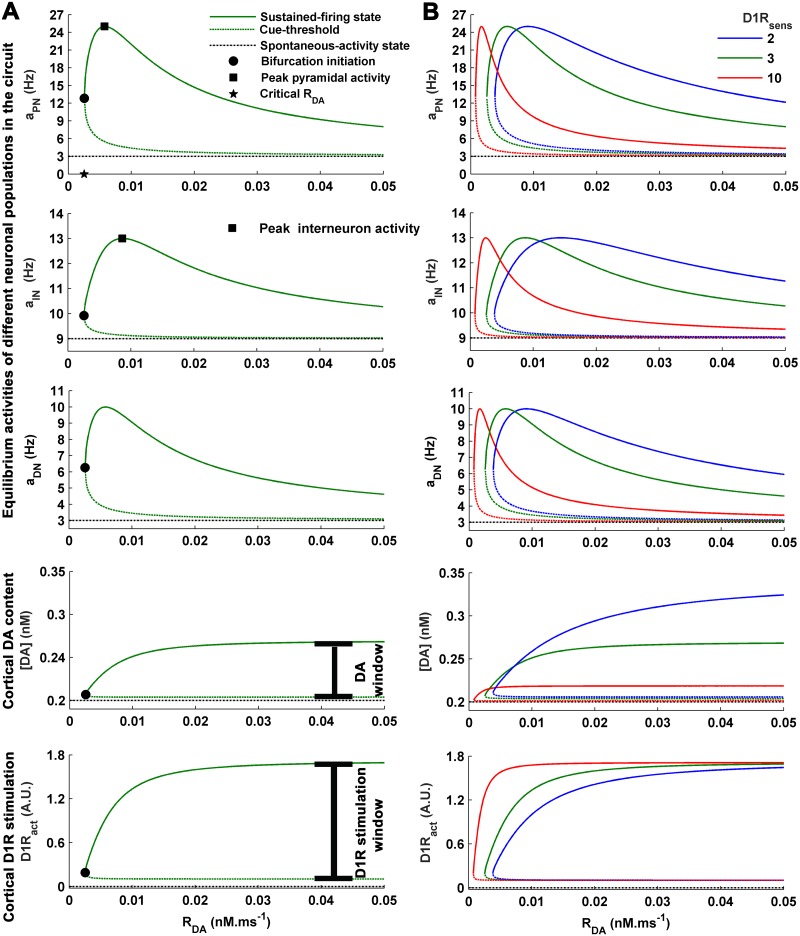
The delay-associated state of the mesocortical dynamics is characterized by the global equilibrium state of its various dynamical elements.(A) Given a fixed value of D1R-sensitivity D1Rsens (here D1Rsens = 3, normal control), the bifurcation profiles of the dynamical elements are shown with DA releasability RDA as the bifurcation parameter. Critical RDA, and the corresponding critical cortical dopamine content [DA] and D1R stimulation level D1Ract, mark the beginning of bistable regime favoring the working memory maintenance during delay period. The higher stable states of the bifurcation profiles are together associated with the sustained-firing state of the cortical dynamics whereas the lower stable states together signify the basal spontaneous-activity state. The ranges of [DA] and D1Ract spanned by their higher stable states represent the spans or windows of cortical DA content and D1R stimulation, respectively, underlying the entire modulation profile of the cortical dynamics. The maximum limit to which [DA] or D1Ract may may increase with increase in RDA marks the saturation level. The cue-threshold in the aPN bifurcation profile signifies the minimum excitation of the pyramidal population by cue input, which causes switching to the sustained-firing state. (B) Alteration in D1Rsens further affects the bifurcation profiles. Most prominently, increase in D1Rsens causes leftward shift of the bifurcation region.